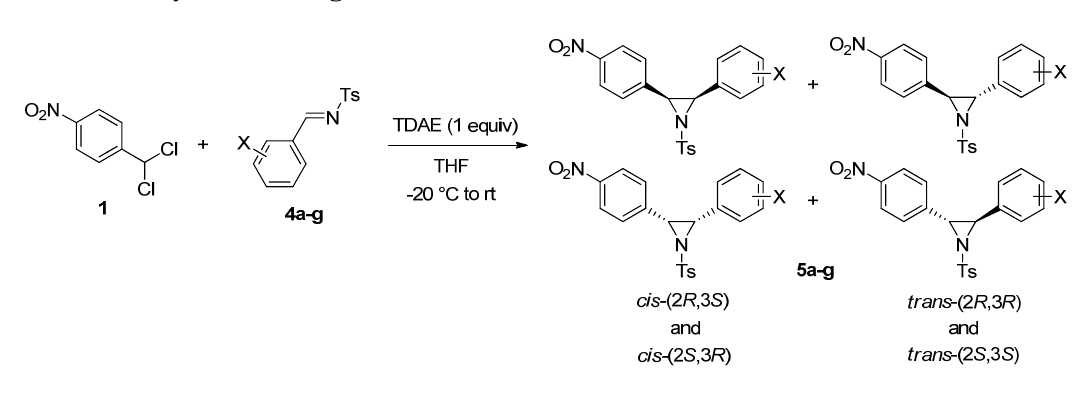
Table 1. Reaction of 1-(dichloromethyl)-4-nitrobenzene ( 1) with aromatic N